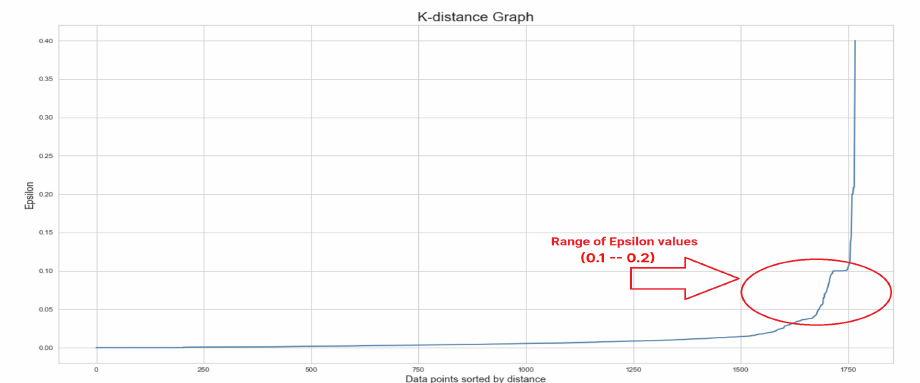
Figure 17. K-distance graph based on 3-dimensional input: Latitude , Longitude , SOG